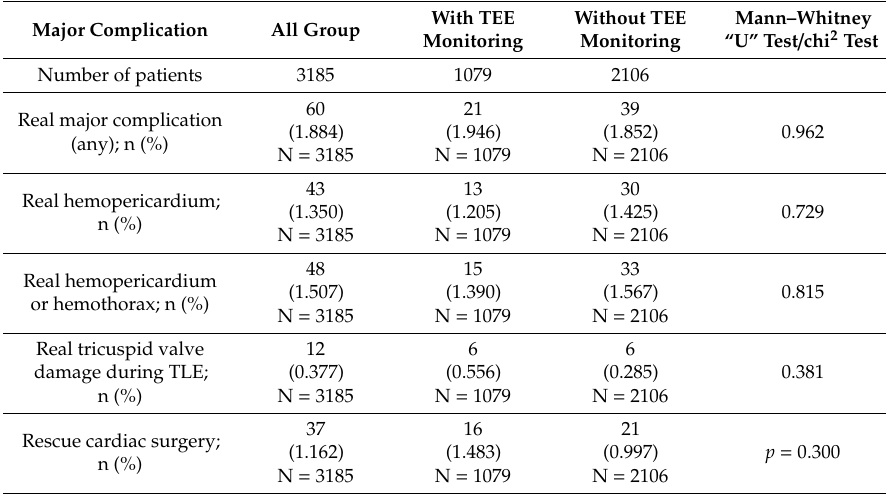
Table 5. Number of real major